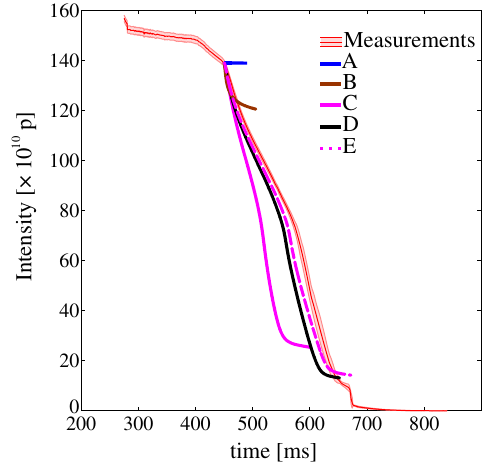
FIG. 4. Half-integer (long bunch simulations): PTC-Orbit simulations vs measurements. Legend: (A) Simulation without errors but with SC; (B) Simulation with errors but no SC; (C) Simulation with only quadrupolar field errors (matching to Q ¼ 4 . 53 ) and SC; (D) Simulation with SC and quadrupolar y field and misalignment errors; (E) Simulation with only quad- rupolar field errors (matching to Q y ¼ 4 . 525 )